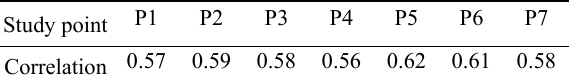
Table 2. Correlations between cumulative surface